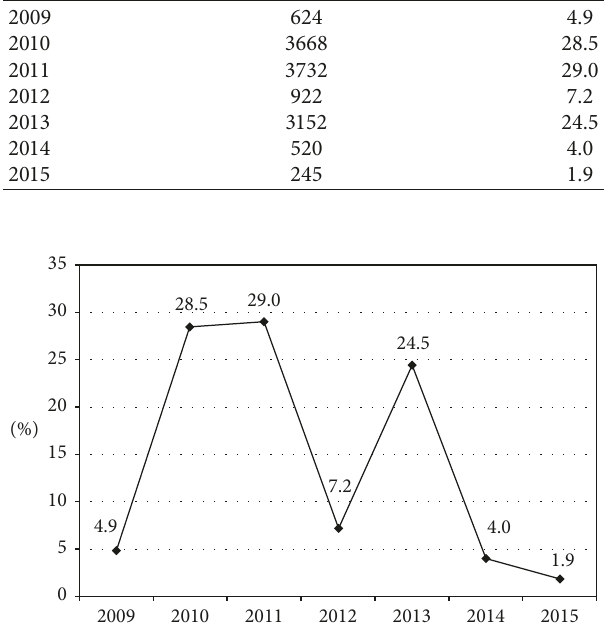
Figure 1: Distribution of the studied samples (2009–2015) in Assiut city. Table 2: Distribution of the studied samples according to